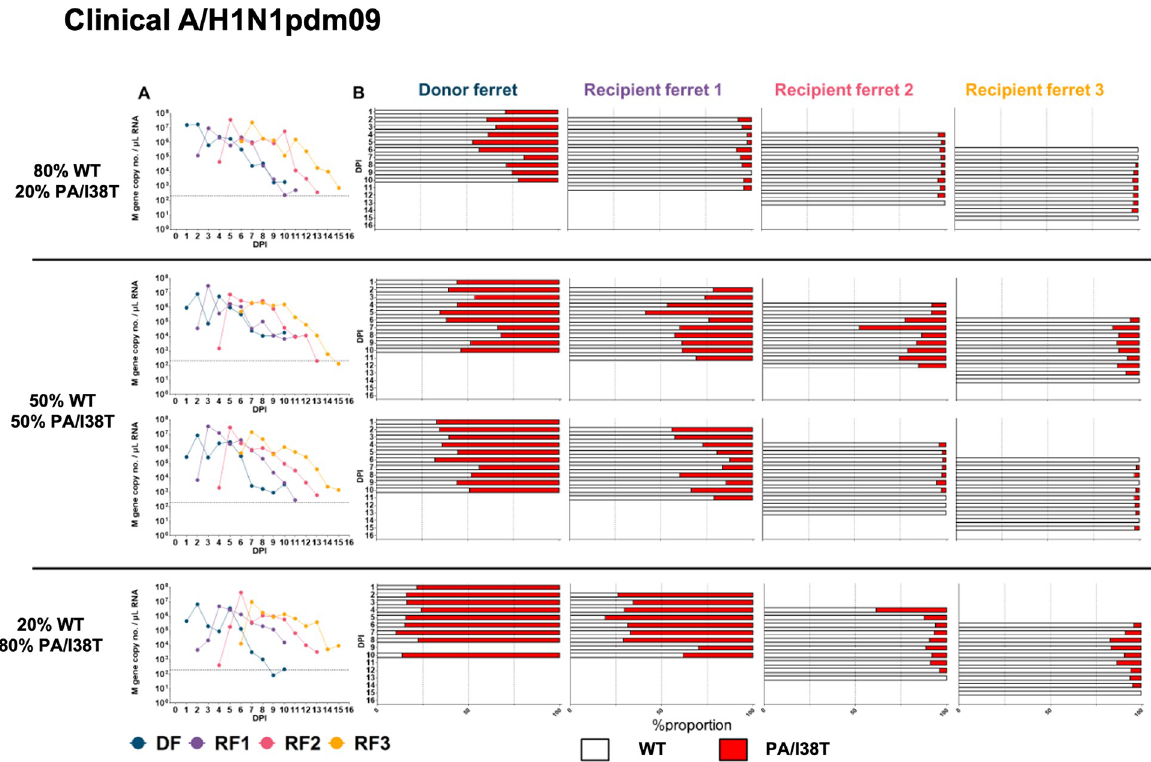
Fig 6. qPCR curves for A/H1N1pdm09 viral RNA and B) WT%:I38T% of viruses in ferret nasal washes. A/H1N1pdm09 DFs were infected (intranasal inoculation) with virus mixtures of WT and PA/I38T at a total infectious dose of 10 4 TCID 50 / 500 μ L. Daily nasal washes were collected from all animals for 10 consecutive days following inoculation/exposure, or until endpoint. RF1 was exposed to the DF by cohousing at 1 DPI. Na ï ve recipients were cohoused sequentially with the previous recipient (1:1) 1 day following detection of influenza A in RF nasal wash (Ct < 35). (A) Viral RNA was quantified by number of M gene copies (influenza A) per μ L of total RNA. (B) The relative proportion of virus encoding WT PA (white bars) and PA/I38T (red bars) in each nasal wash sample was determined by pyrosequencing. DF, donor ferret; DPI, days post inoculation; PA, polymerase acid; RF, recipient ferret; TCID 50 , 50% tissue culture infectious dose; WT, wild type.